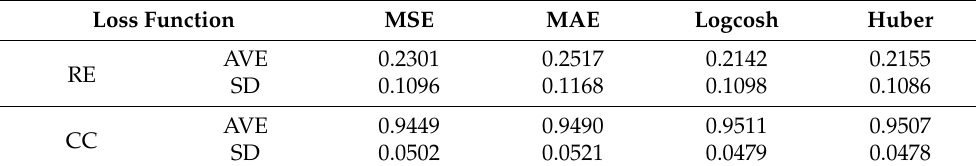
Table 2. The RE and CC of all samples in the test set with different loss functions.